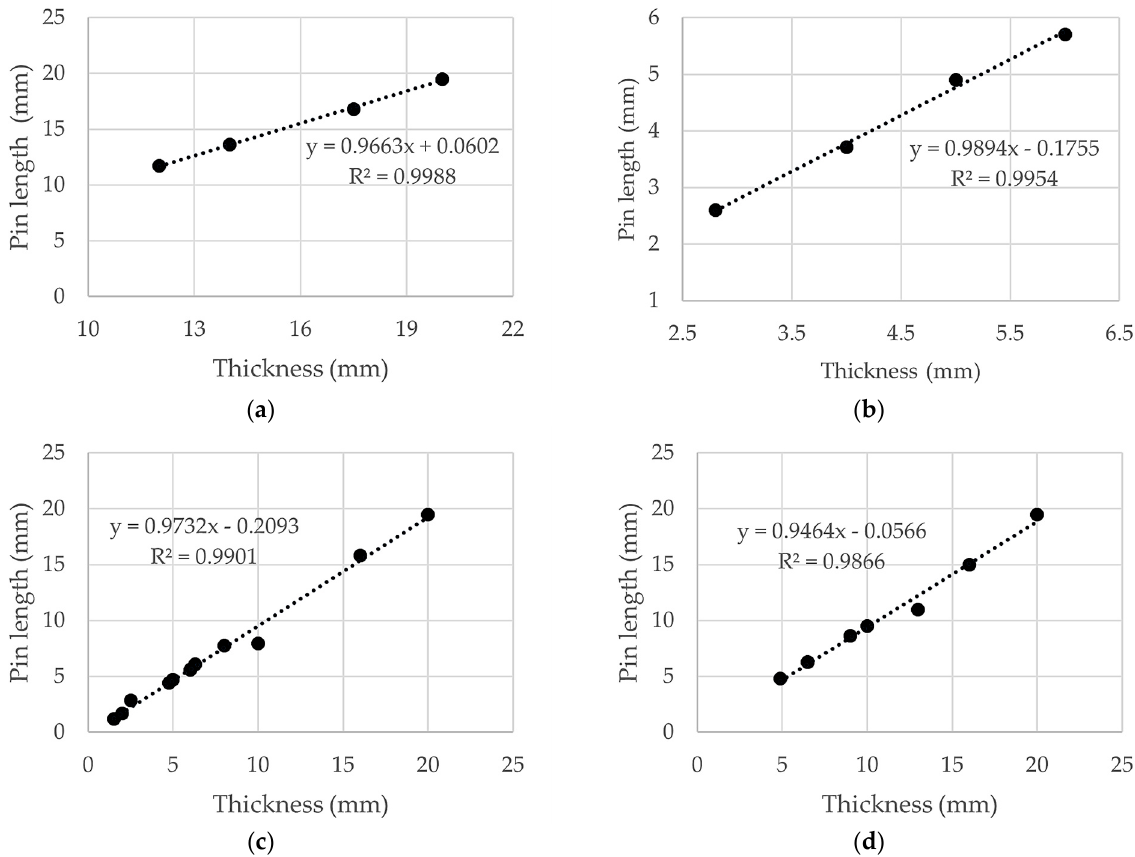
Figure 5. Pin length vs. thickness for series: ( a ) 2XXX; ( b ) 5XXX; ( c ) 6XXX; and ( d ) 7XXX.